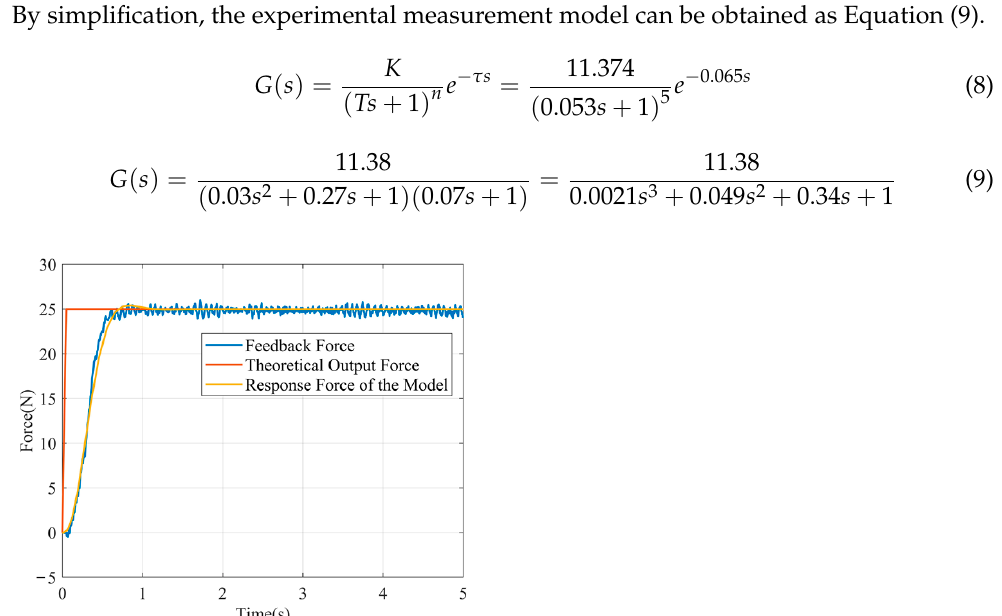
Figure 3. The transfer function block diagram of the end-e ff ector system.